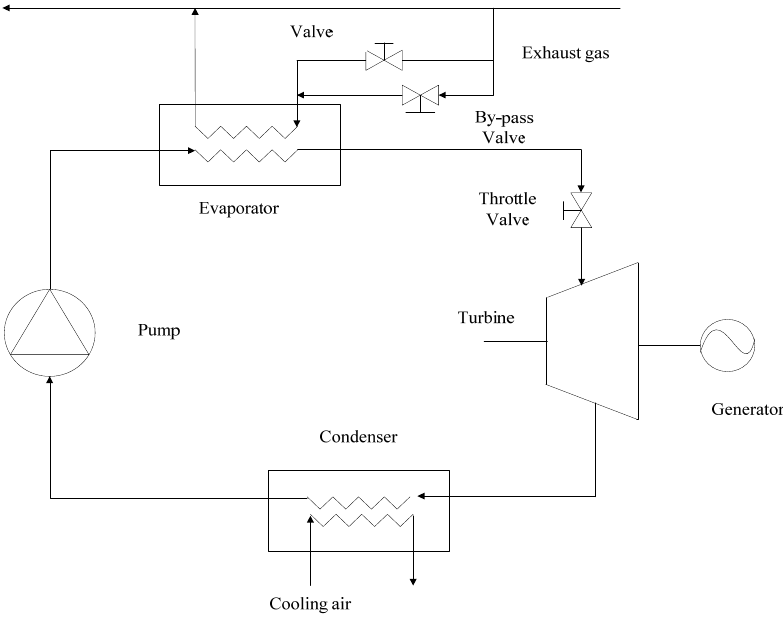
Figure 1. A simplified diagram of a waste heat recovery